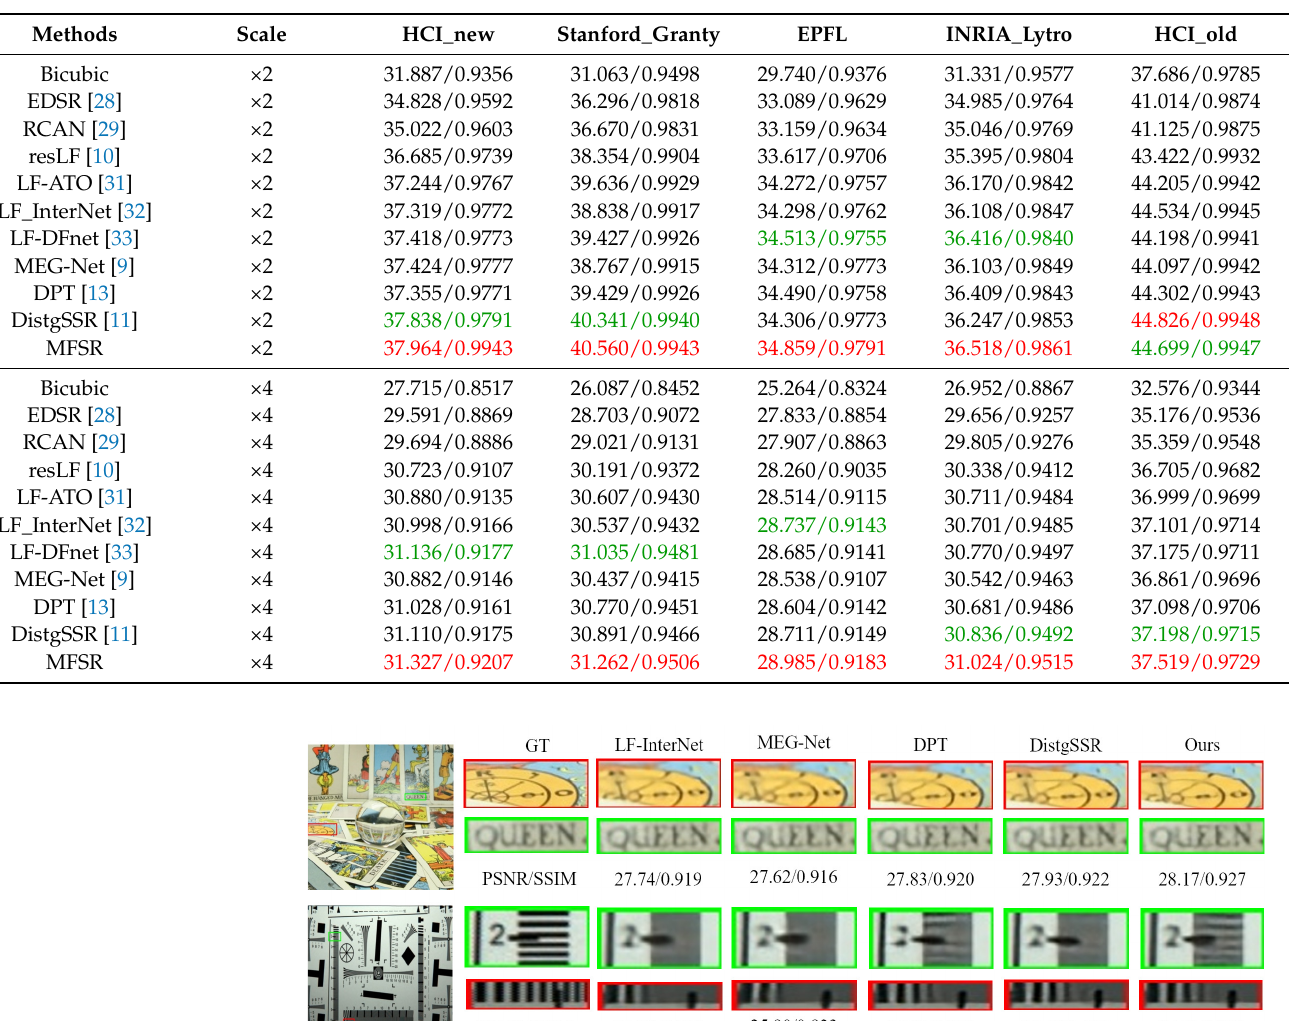
Table 4. PSNR/SSIM values achieved by different methods for 2 × and 4 × SR. The best results are in red and the second best results are in green.